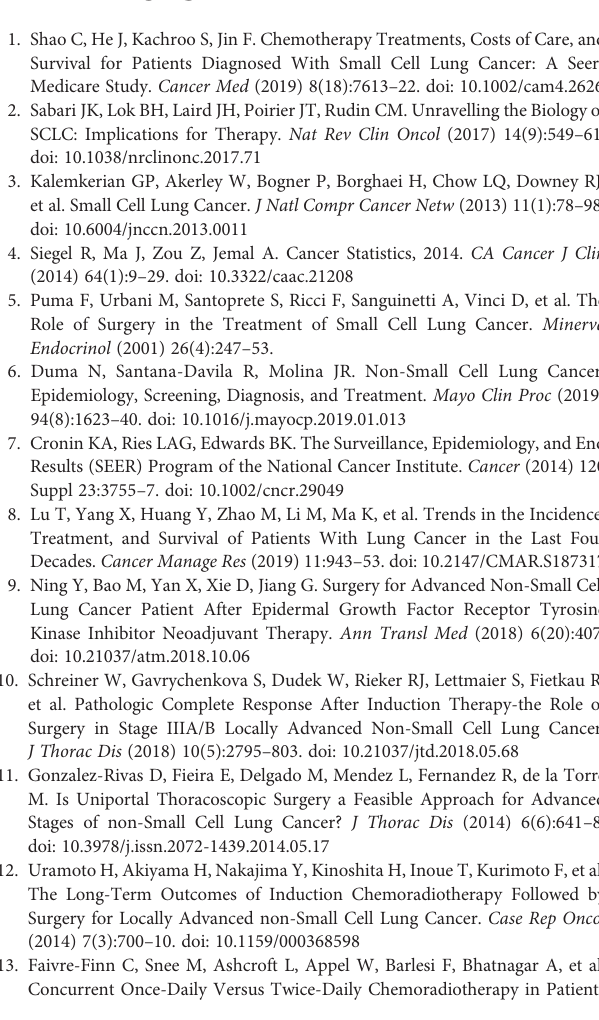
Supplementary Figure 4 | Survival analyses of overall survival (OS) for patients with AJCC stage II SCLC receiving chemotherapy-plus-surgery or surgery-alone treatment. (A) Kaplan-Meier analysis of OS before matching; (B) Kaplan-Meier analysis of OS after matching; (C) Kaplan-Meier analysis of OS after IPTW analysis;